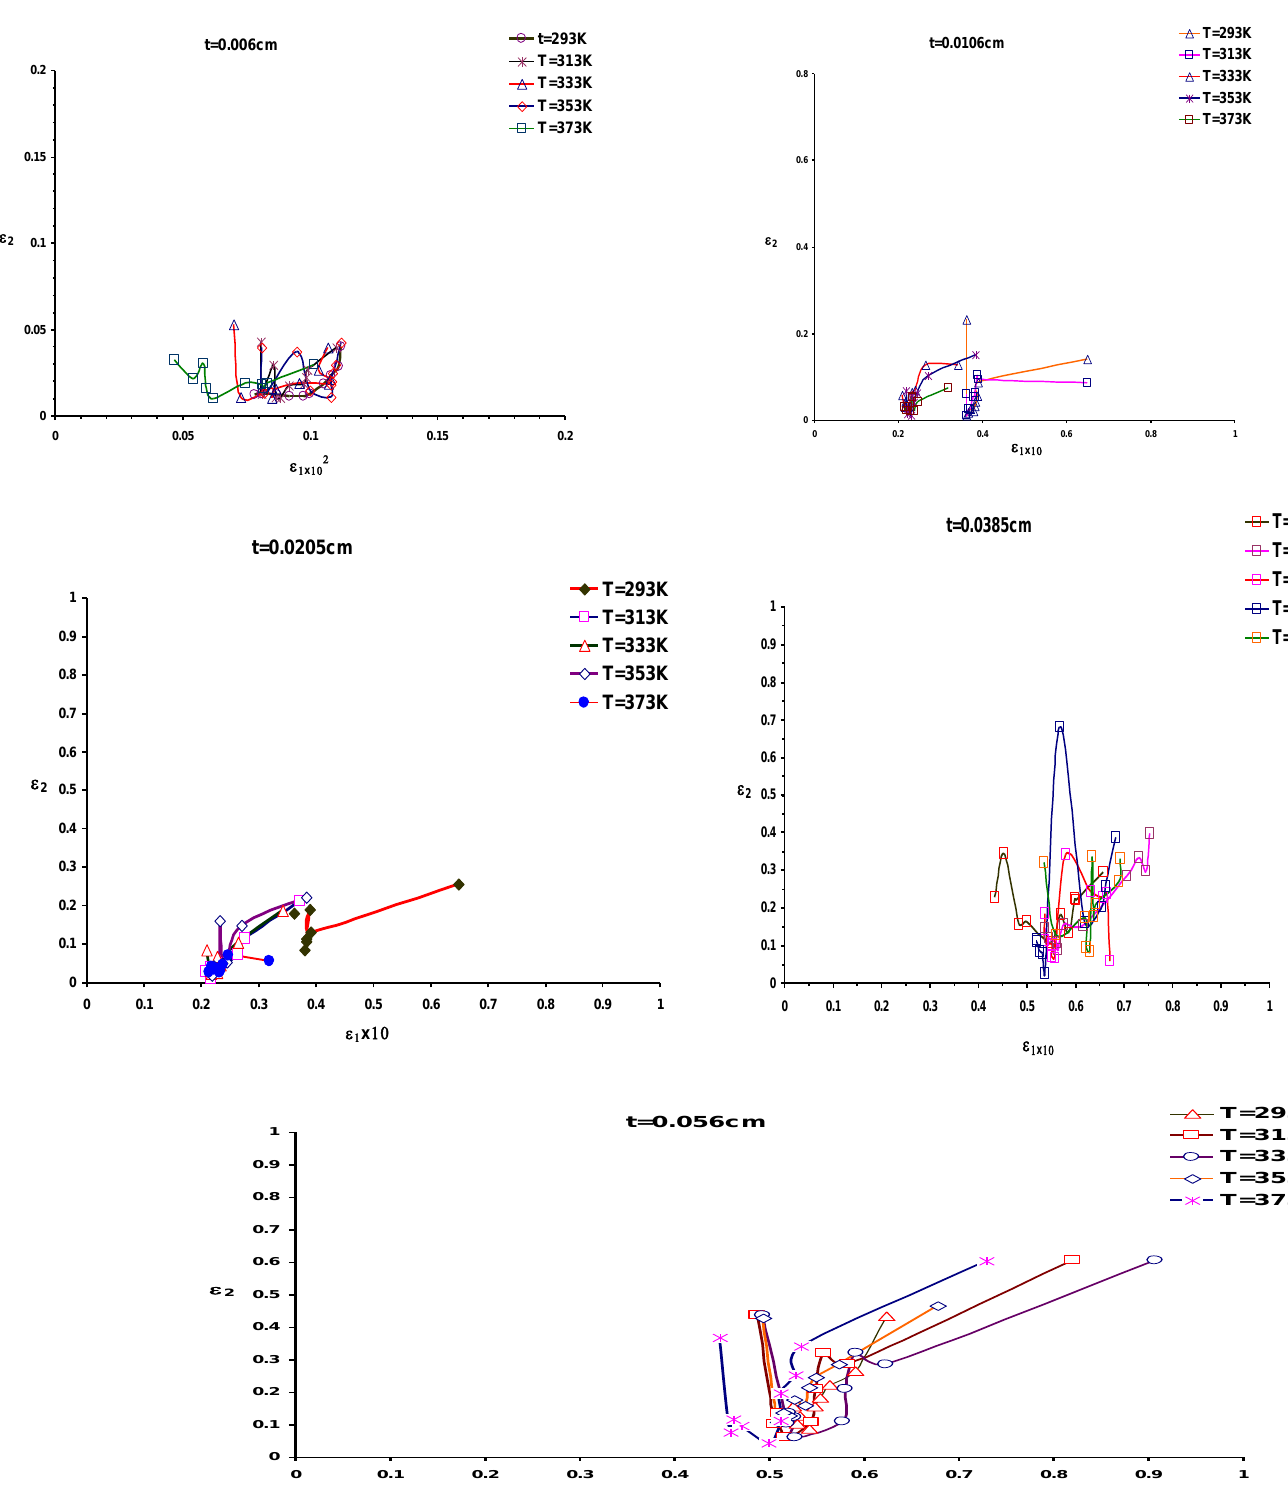
Fig.9: Cole – Cole diagrams of PMMA films for different thickness and